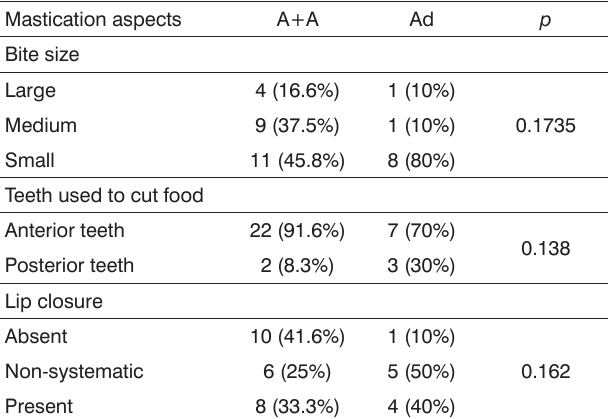
Table 1. Comparison of frequencies of occurrence of mastica- tion aspects in children with adenotonsillar hypertrophy (group A+A) and children with adenoid hypertrophy (group Ad) based on Fisher’s exact test.